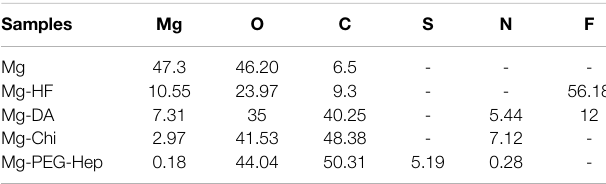
TABLE 1 | The surface atom percentages (wt%) of the different samples characterized by X-ray photoelectron spectroscopy (XPS).